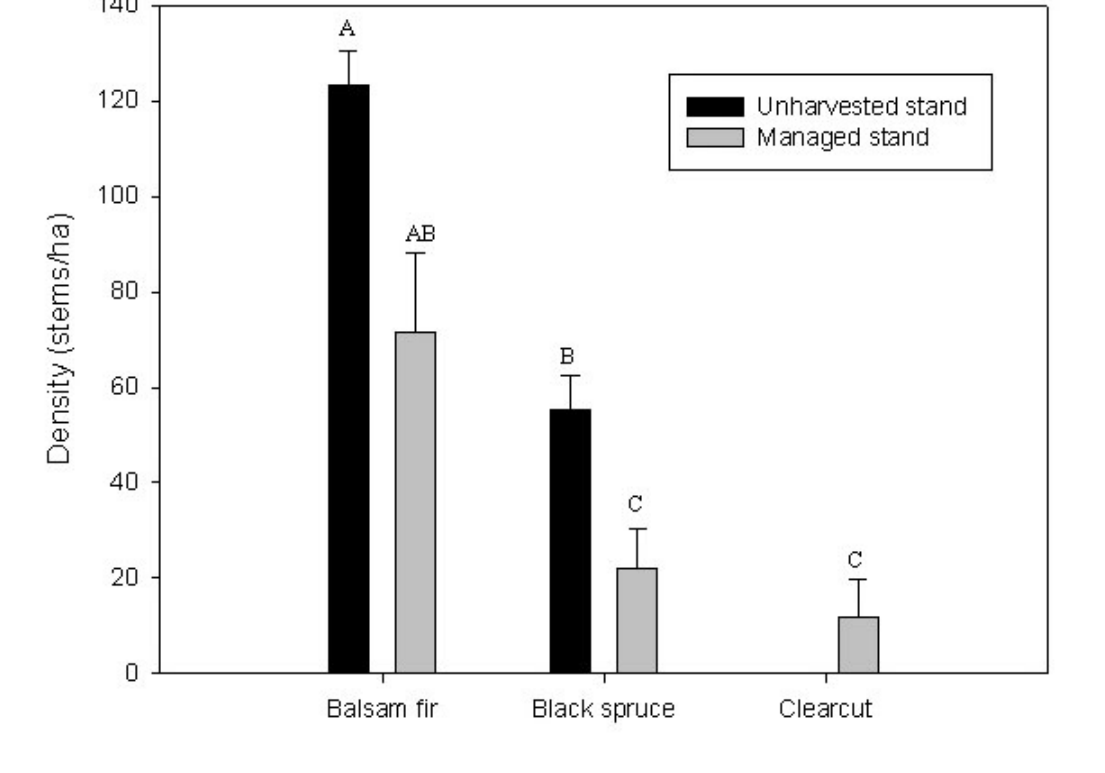
Fig. 4 . Mean densities of potential cavity-trees with regard to stand type in unharvested stands, remnant stands, and clearcuts of balsam fir ( Abies balsamea ) and black spruce ( Picea mariana ) in the Chauvin and Martin-Valin controlled wildlife harvesting zones, Quebec, Canada. This figure shows that the availability of potential cavity-trees is significantly reduced in managed stands. Different letters indicate a significant difference between treatments at P = 0.05 using the Tukey’ hsd test. The five treatments were compared